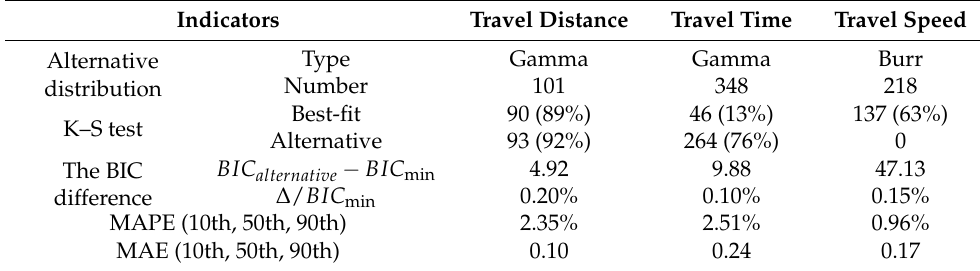
Table 5. Fitting indicators of alternative distributions for three trip